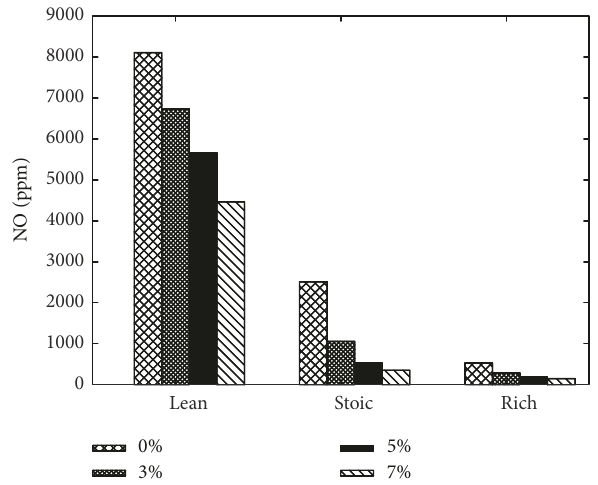
Figure 9: Effects of RGF and equivalence ratio on engine-out NO (ppm).